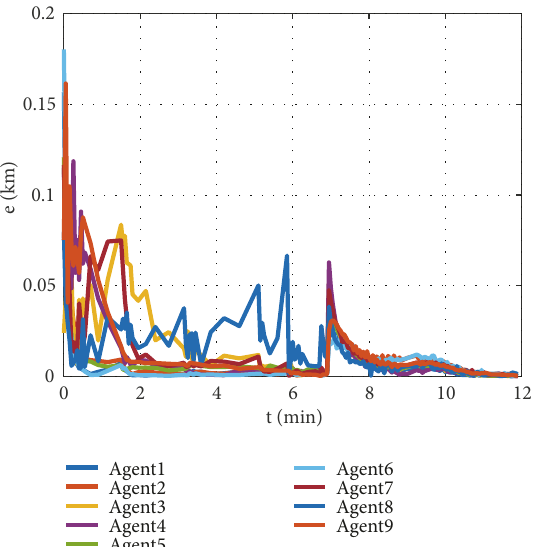
(a) The cost function with regulable sampling mechanism